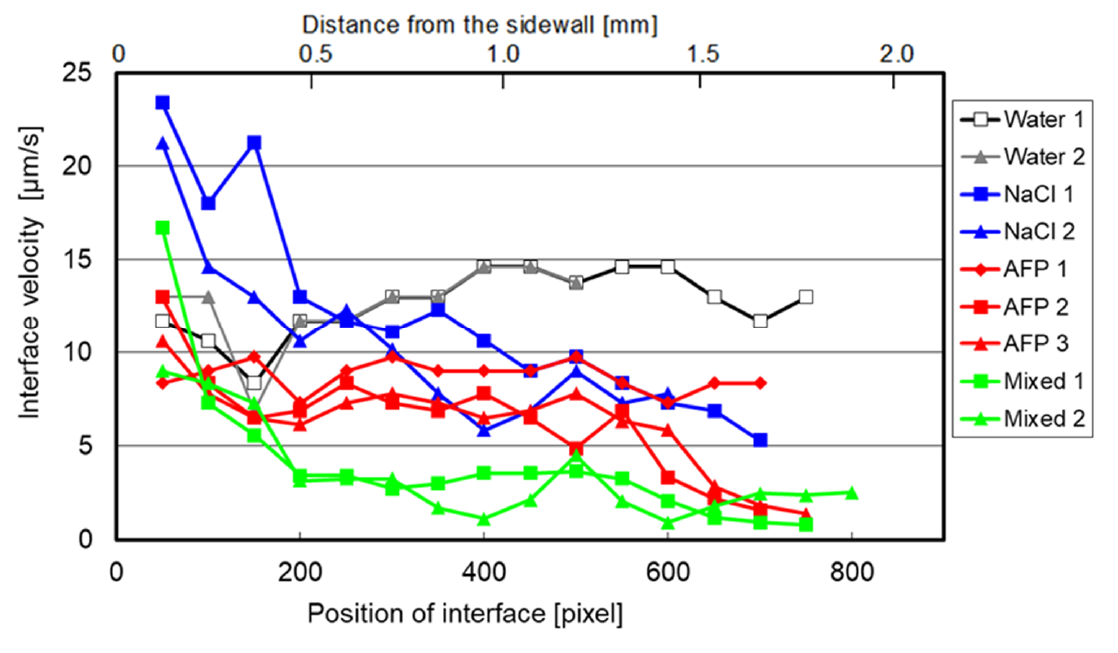
Figure 5. Interface velocity as function of distance from sidewall.